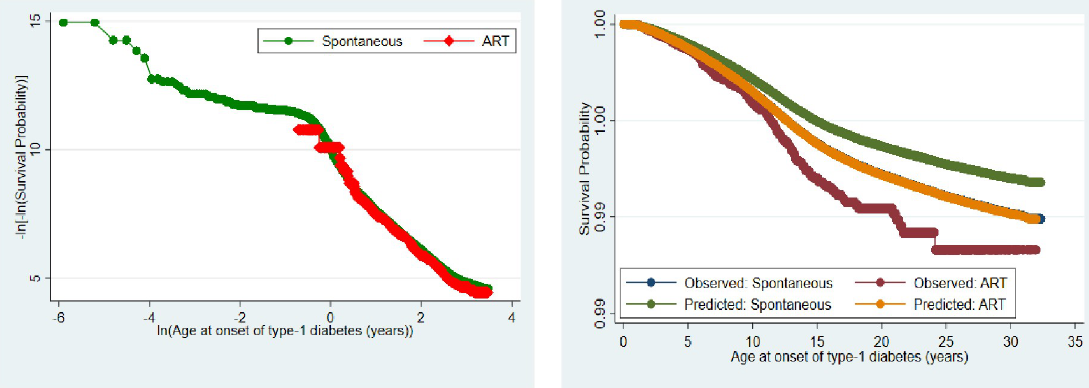
Fig 2. Proportionality of survival curves of onset of type-1 diabetes among ART and spontaneously conceived children.